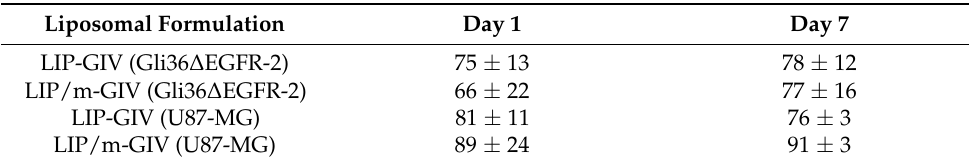
Table 2. Cell mortality (% of control ± SD) in 3D-bioprinted models after treatment with LIP-GIV or LIP/m-GIV.